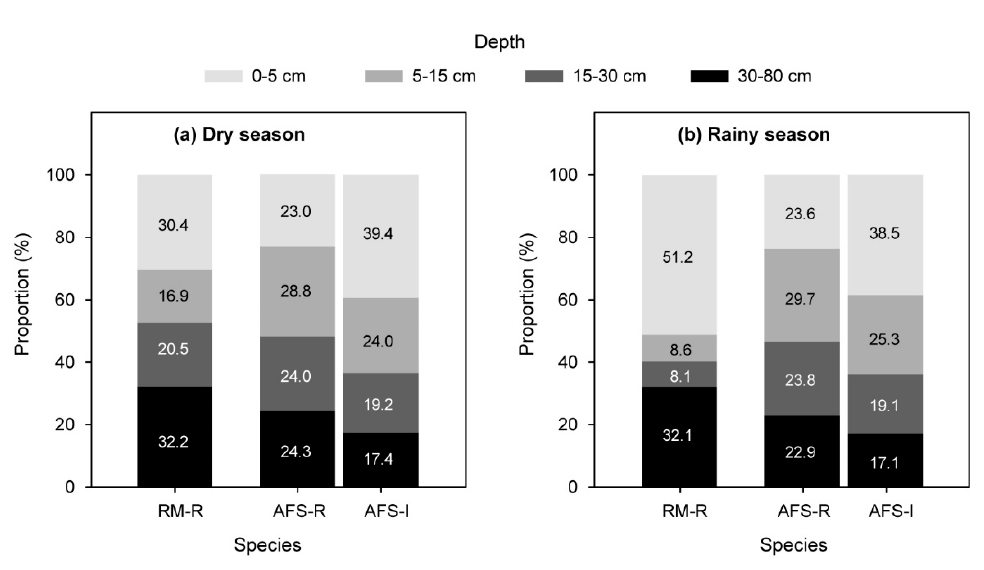
Figure 3. Mean water-absorbing proportion of each plant species in ( a ) the extremely dry season and ( b ) the pronounced rainy season. “RM-R” indicates rubber trees in the rubber monoculture. “AFS-R” and “AFS-I” indicate rubber trees and intercrops in the agroforestry system, respectively.